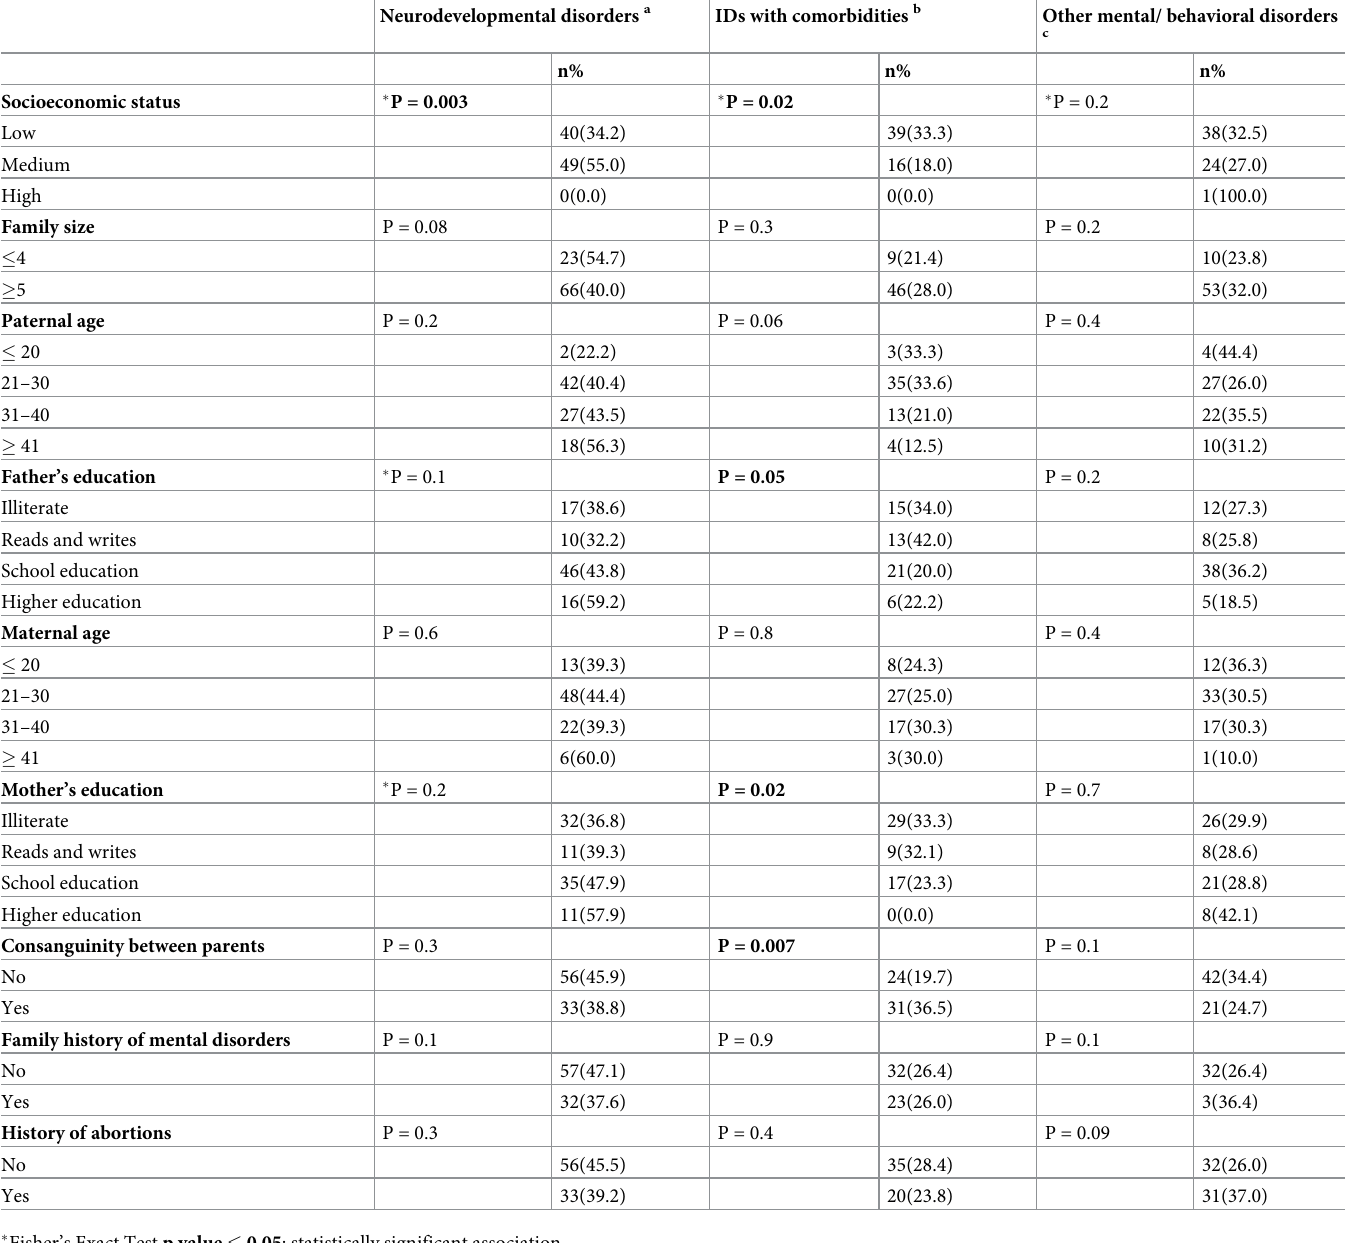
Table 7. Chi-square association test of sociodemographic variables (family characteristics) and